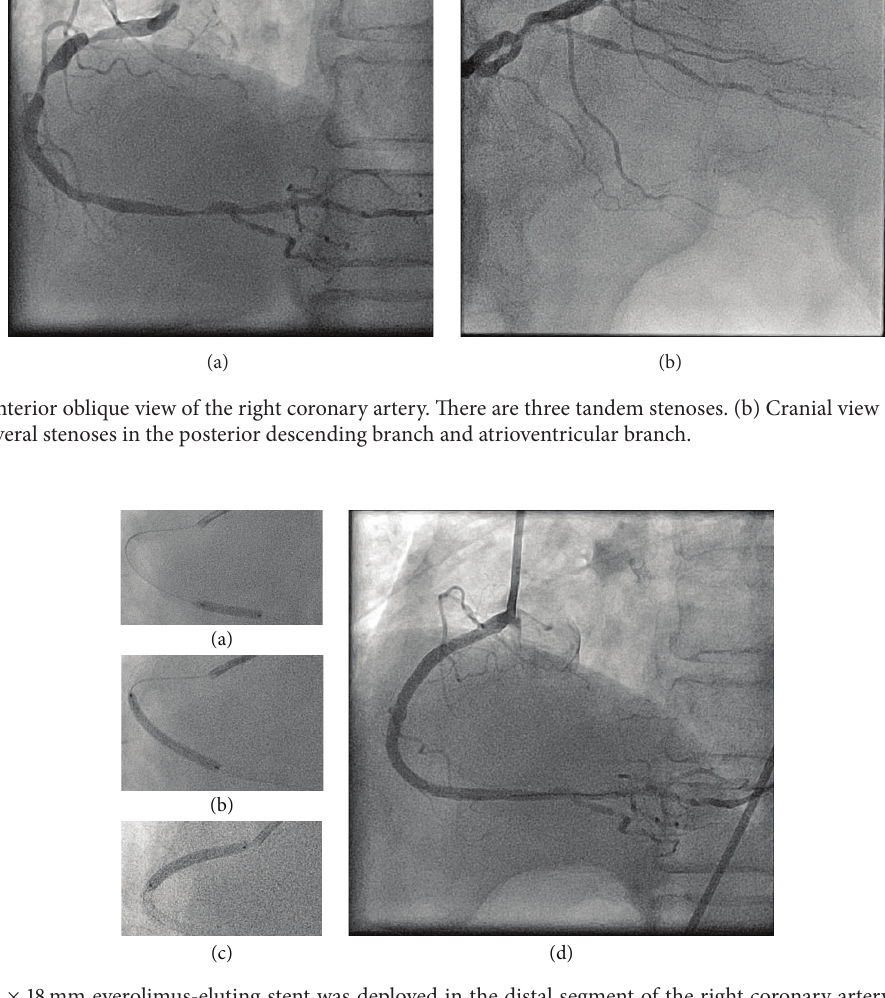
Figure 2: (a) A 3.0 × 18mm everolimus-eluting stent was deployed in the distal segment of the right coronary artery. (b) A 3.0 × 38 mm everolimus-eluting stent was deployed in the middle segment of the right coronary artery. (c) A 3.5 × 38 mm everolimus-eluting stent was deployed in the proximal segment of the right coronary